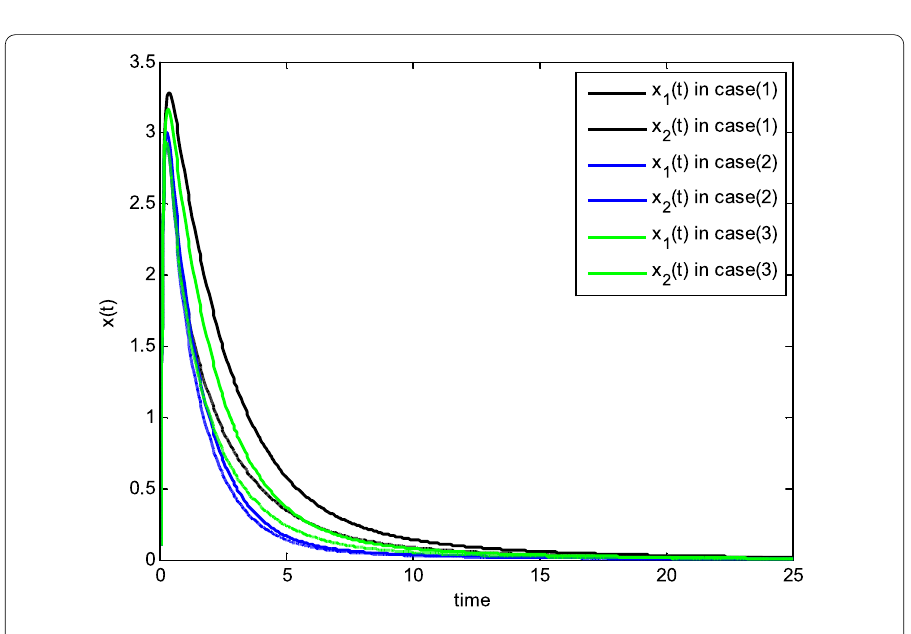
Figure 3 The time response of the system in 3